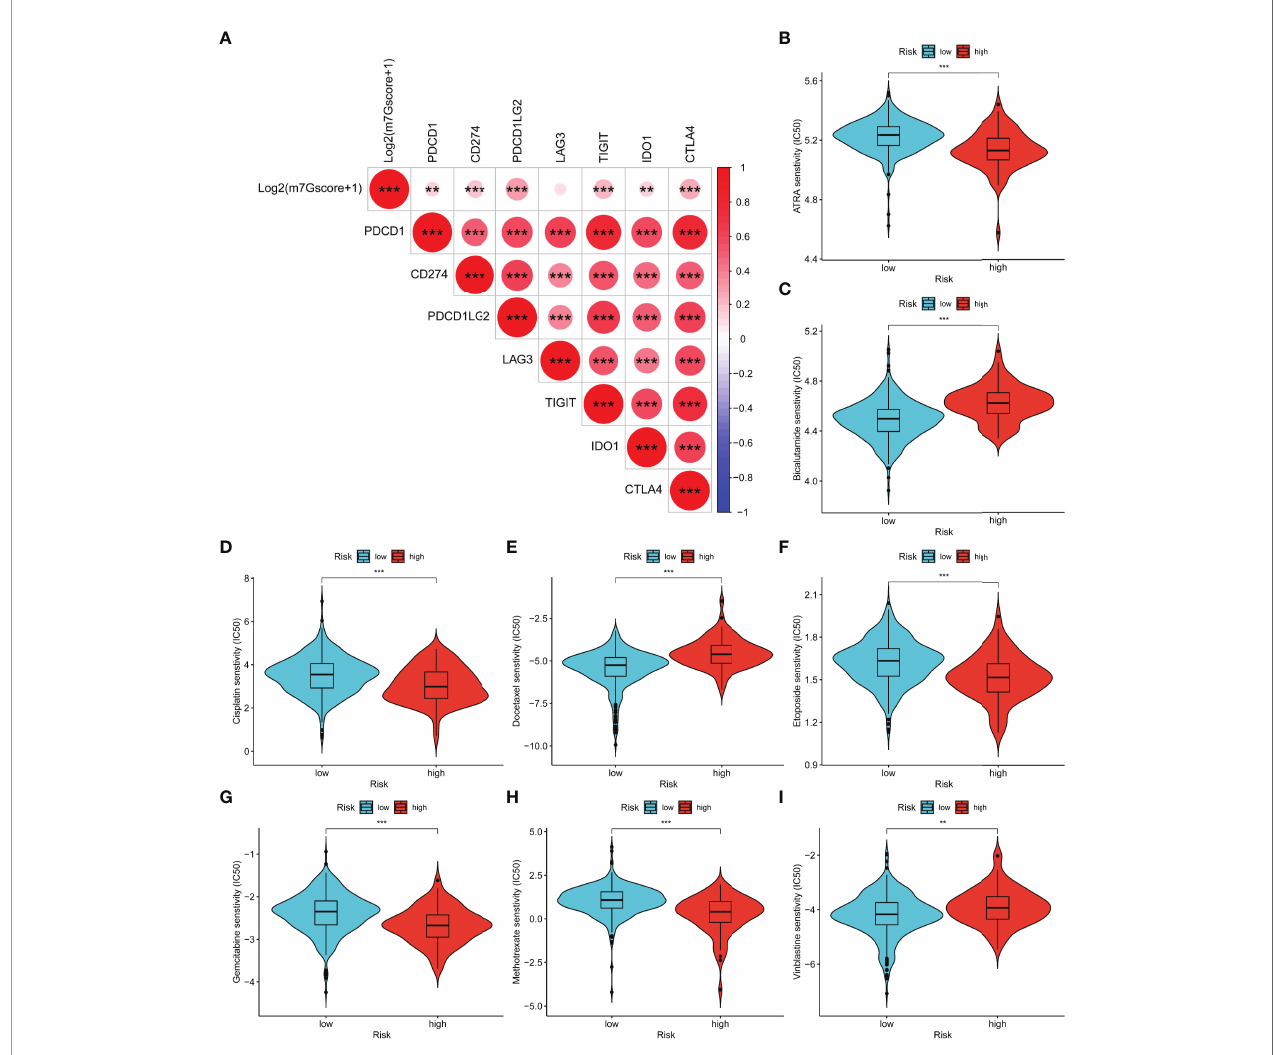
FIGURE 11 | Relevance between m7Gscore and drug sensitivity. (A) The prediction of immunotherapy ef fi cacy with the correlation between m7Gscore and immune checkpoint expression. (B – I) The IC50 of m7Gscore-de fi ned subgroups to drugs, including ATRA (B) , bicalutamide (C) , cisplatin (D) , docetaxel (E) , etoposide (F) , gemcitabine (G) , methotrexate (H) , and vinblastine (I) . **p < 0.01; ***p <